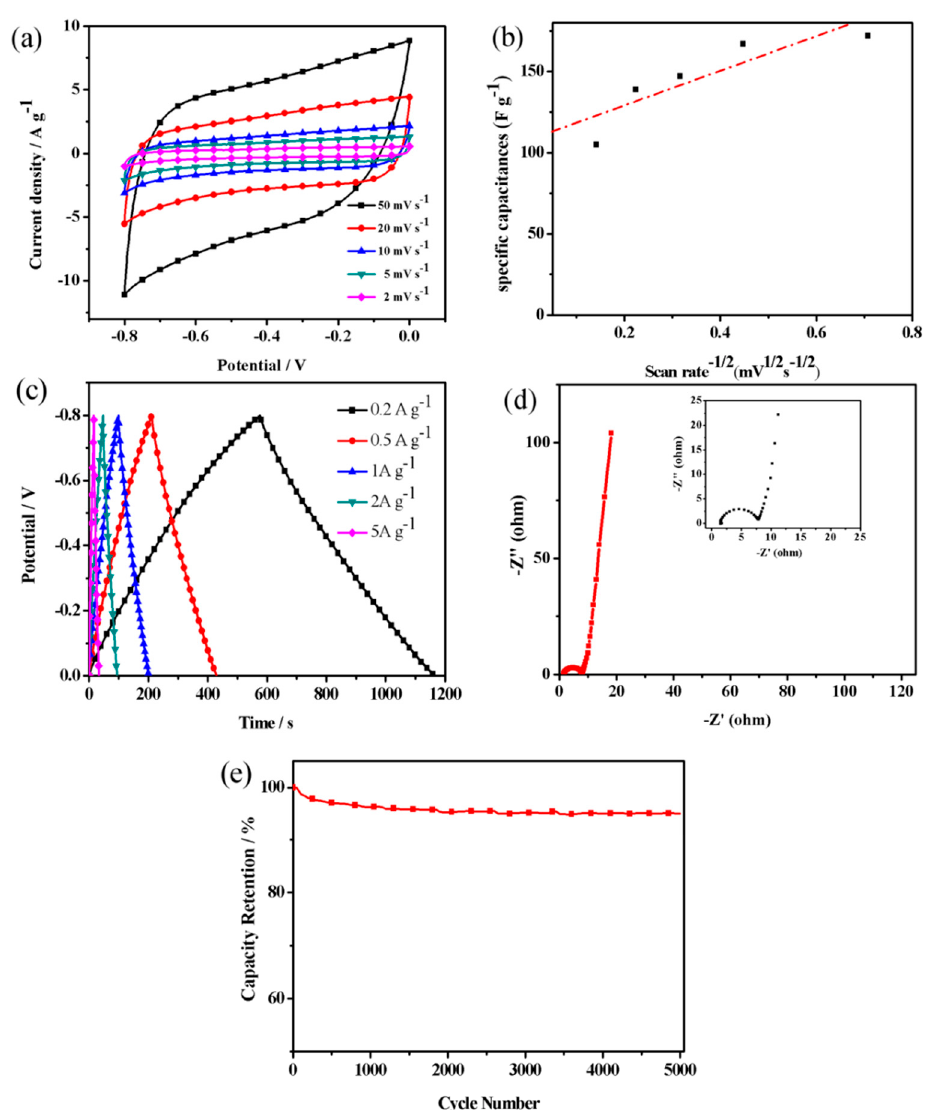
Figure 8. ( a ) CV curves at different scan rates; ( b ) a plot of specific capacitance vs scan rate − 1/2 ; ( c ) GCD curves at different current densities; ( d ) Nyquist plots of NCFs’ electrodes in the frequency range of 0.01 Hz–100 kHz; and ( e ) cycling performance of NCFs electrode. Table 1. Comparison of specific capacitance values with recent reported literature in a three-electrode cell